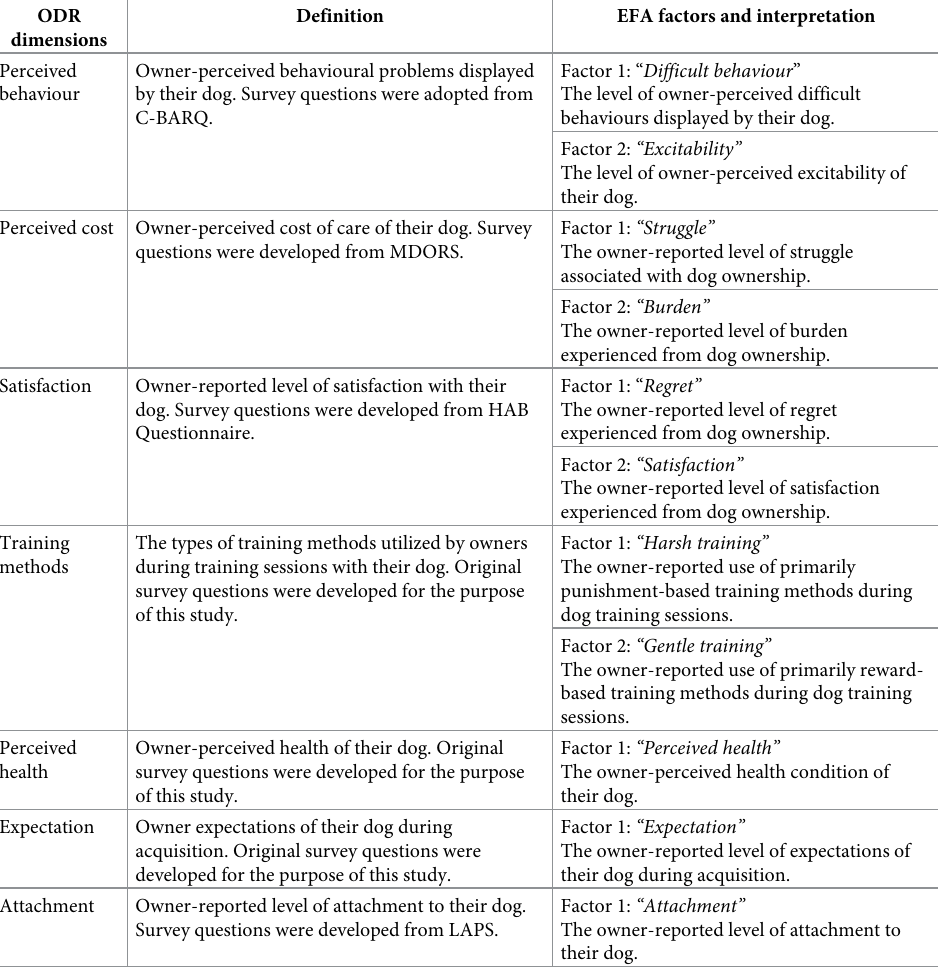
Table 1. Owner-dog relationship dimensions and extracted